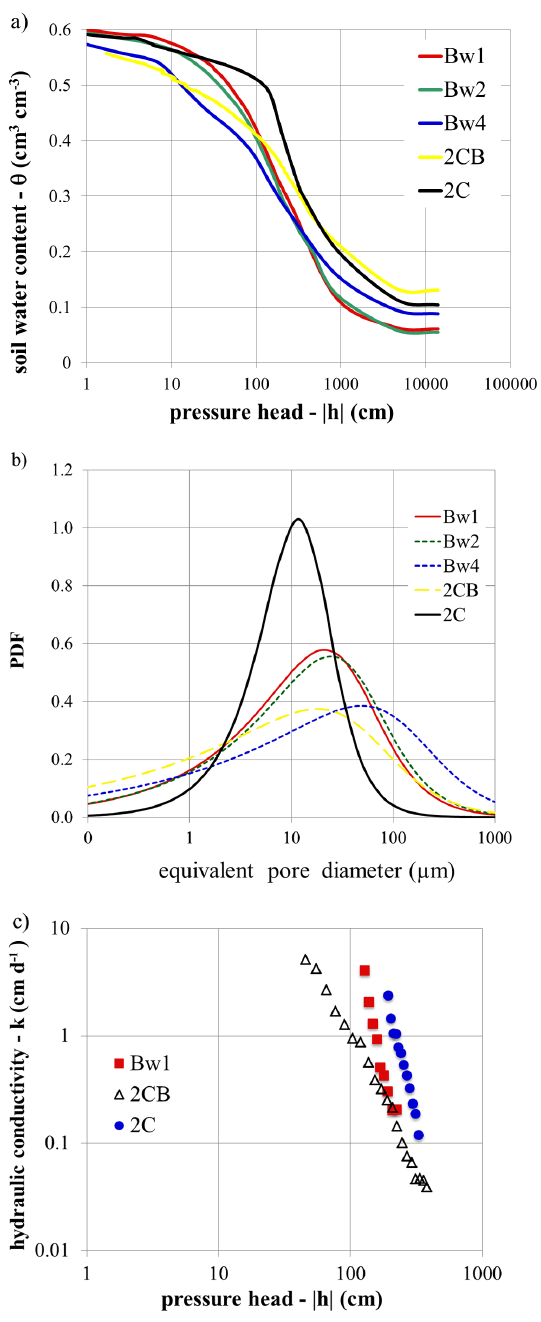
Figure 3. Hydraulic properties of selected horizons along soil pro- file P2: (a) water retention curves, (b) equivalent pore size distribu- tions and (c) hydraulic conductivity